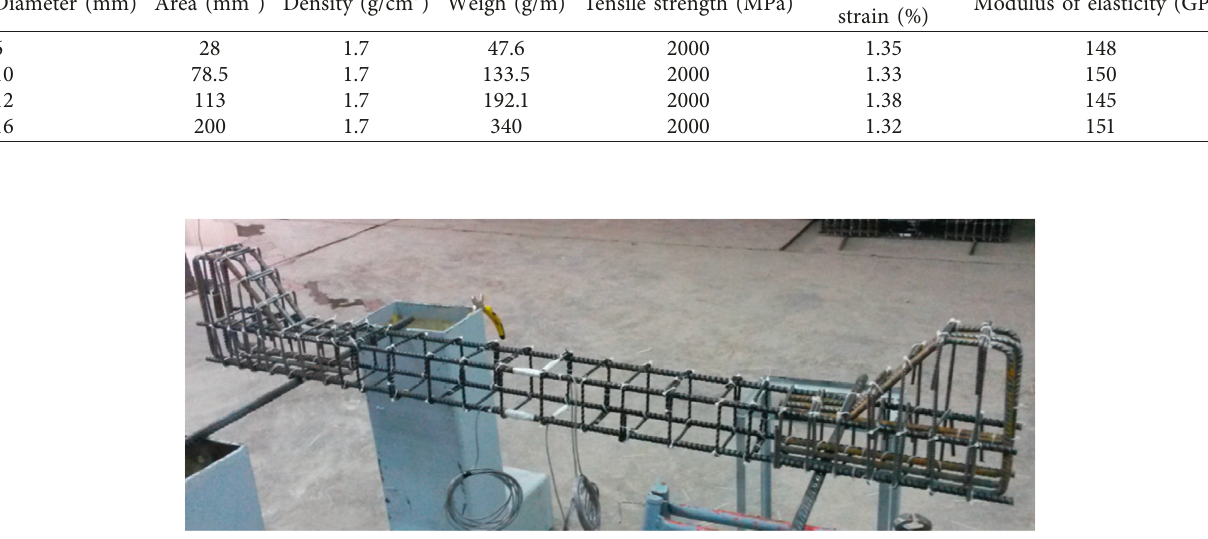
Figure 2: Typical reinforcement